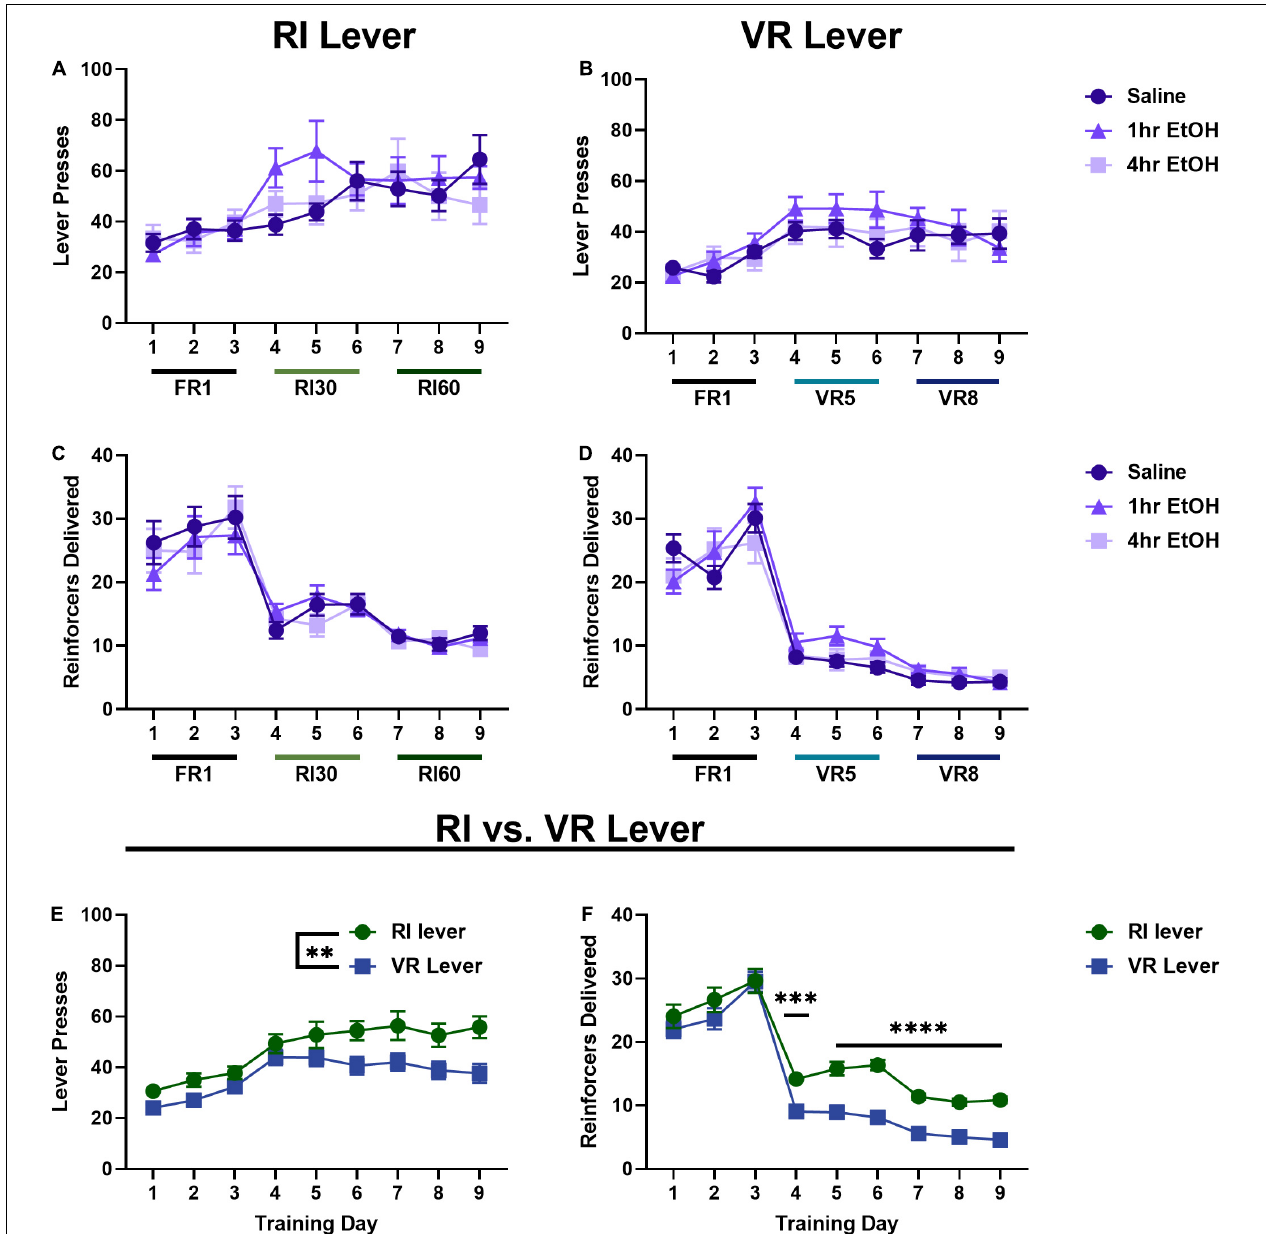
FIGURE 2 | Reinforcer schedule but not ethanol exposure impacts reward seeking in females. In females, there is also no effect of low dose ethanol exposure on responding on the RI (A) or VR (B) lever. There is also no effect of low dose ethanol exposure on reinforcer delivery on the RI (C) or VR (D) lever. Overall,